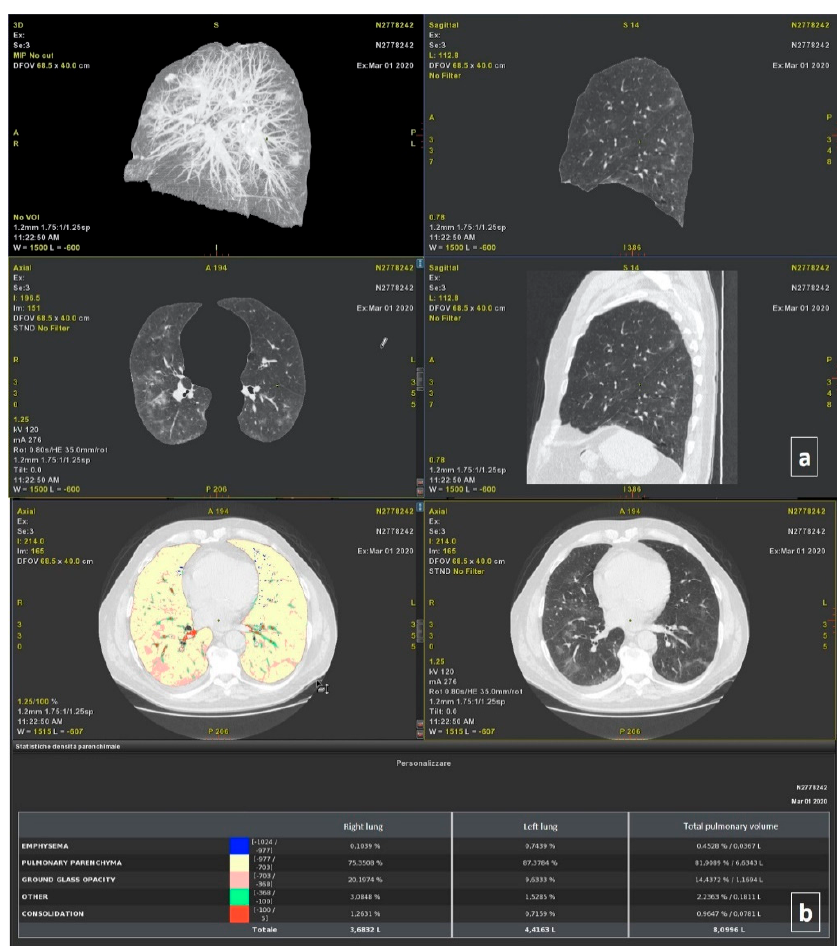
Figure 1. Automatic Segmentation of Thoracic Disease by COVID-19 using the Thoracic VCAR Tool of General Electric Healthcare: ( a ) 3D axial and sagittal plane reconstruction; ( b ) Density analysis of parenchyma. This case had bilateral and diffuse ground-glass opacity (GGO) and consolidations in multiple lobes.